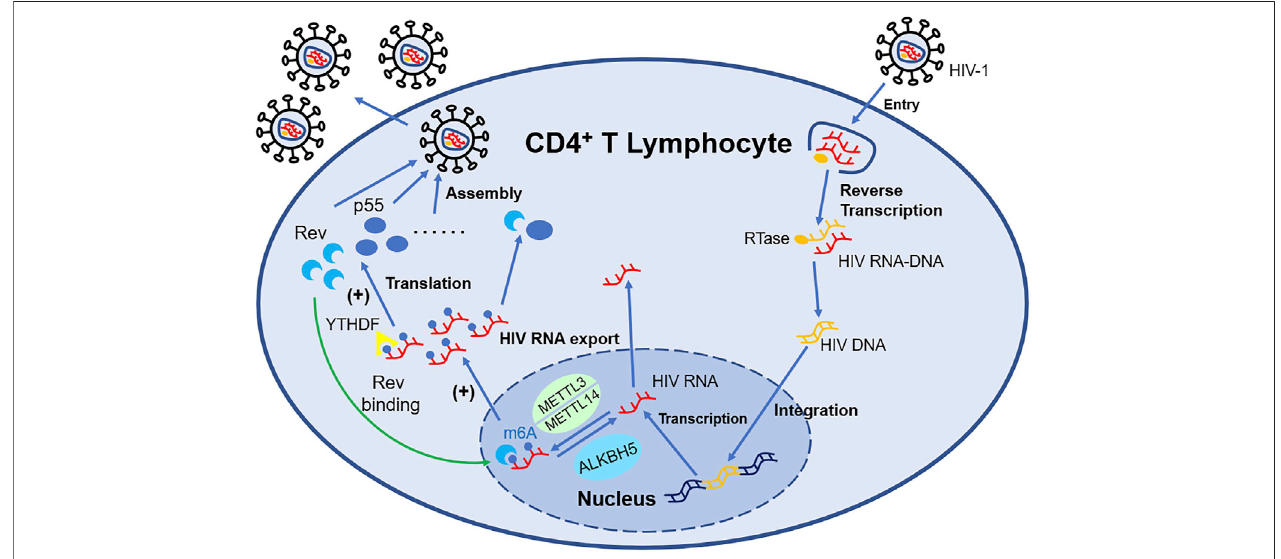
FIGURE 2 | m 6 A-associated proteins in HIV-infected T lymphocytes regulate the expression of HIV mRNA. METTL3/METTL14 can install m 6 A decoration on HIV mRNA,whileALKBH5canremovesuchmodi fi cation.YTHDF1-3recognizethem 6 Astructureandin fl uencetheexpressionofHIVmRNAsuchasRevandp55.Withthe support of Rev, HIV mRNA modi fi ed by m 6 A can export nucleus more easily, which promote the replication of HIV.